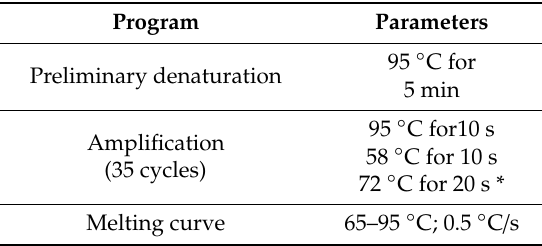
Table 2. Conditions of the qPCR reaction for the investigated genes, StEXPA3 and StEXT4 , and the reference. Fluorescence signal reading set on the end of the stage is marked by an asterisk